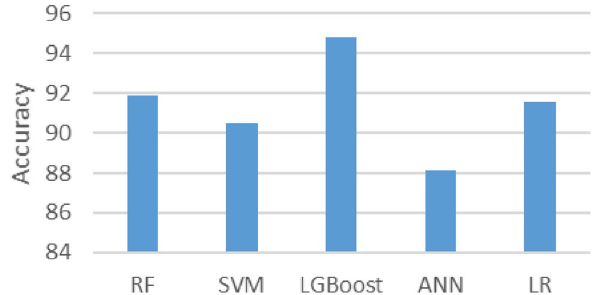
Fig. 19 Accuracy of different machine learning algorithm used in